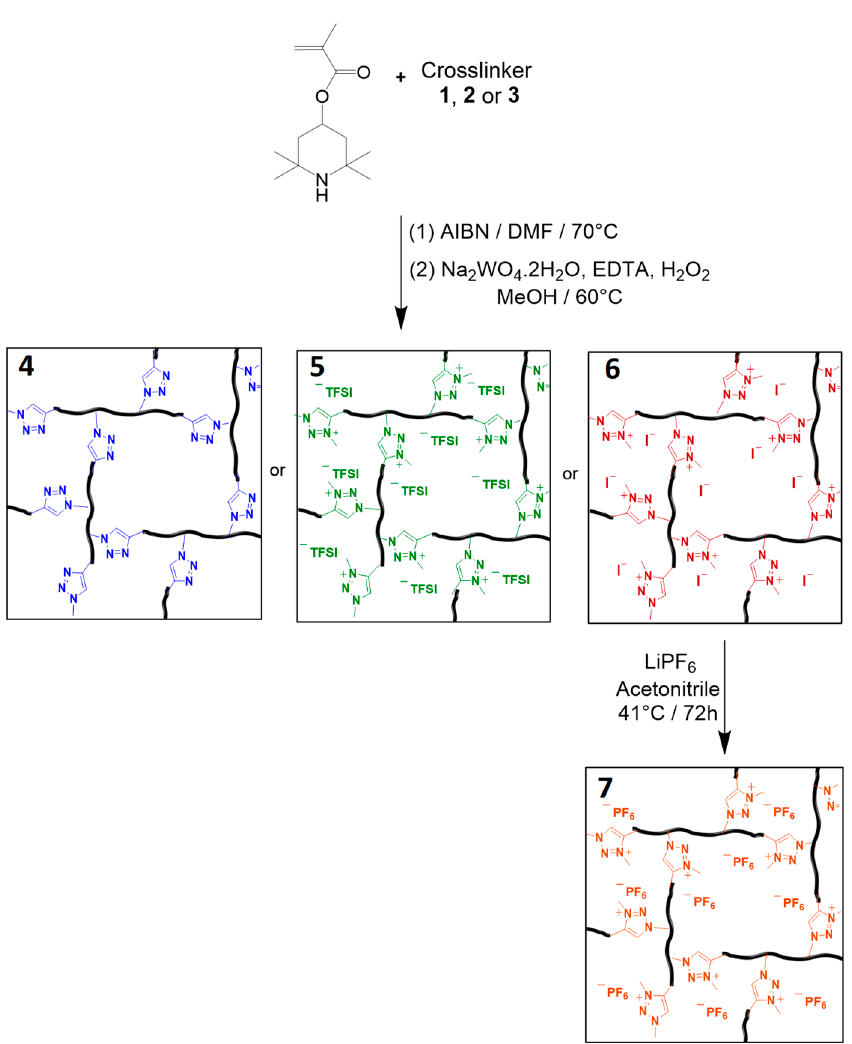
Figure 4. Synthesis of PTMA gels with different crosslinkers, ( 4 ) triazole gel, ( 5 ) triazolium + /TFSI − gel, ( 6 ) Triazolium + /I − gel and ( 7 ) triazolium + /PF6 − gel.